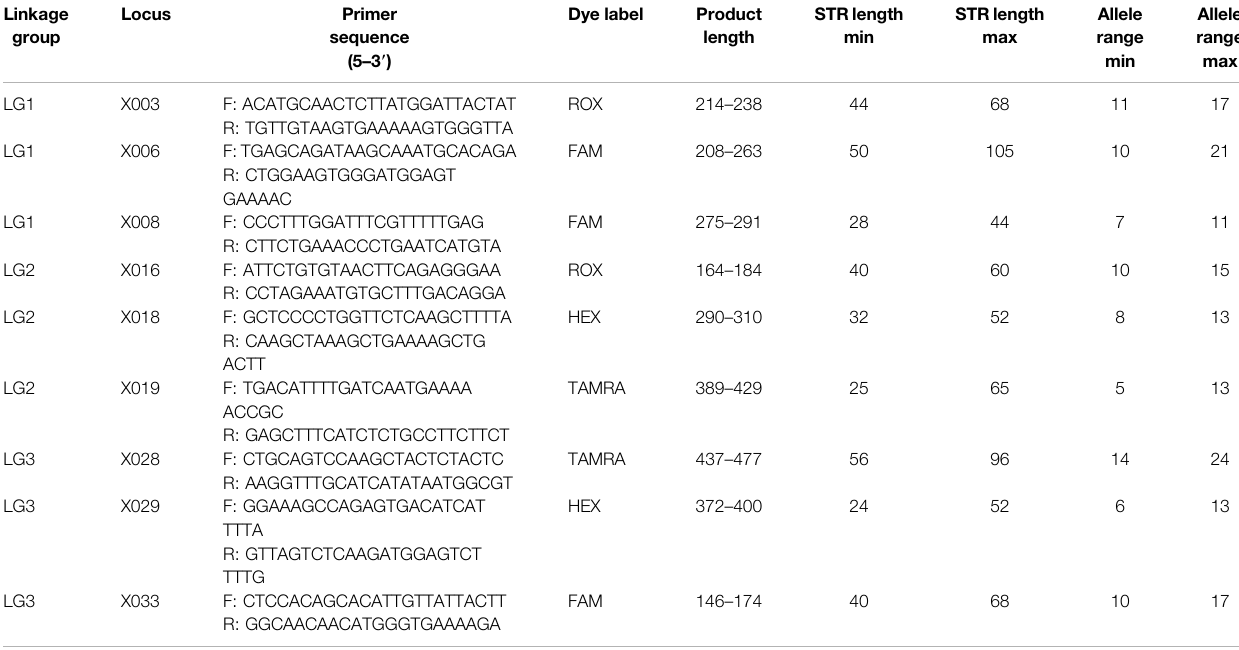
TABLE 1 | Details of the multiplex system of the nine X-chromosomal short tandem repeats (X-STRs). Linkage Locus group